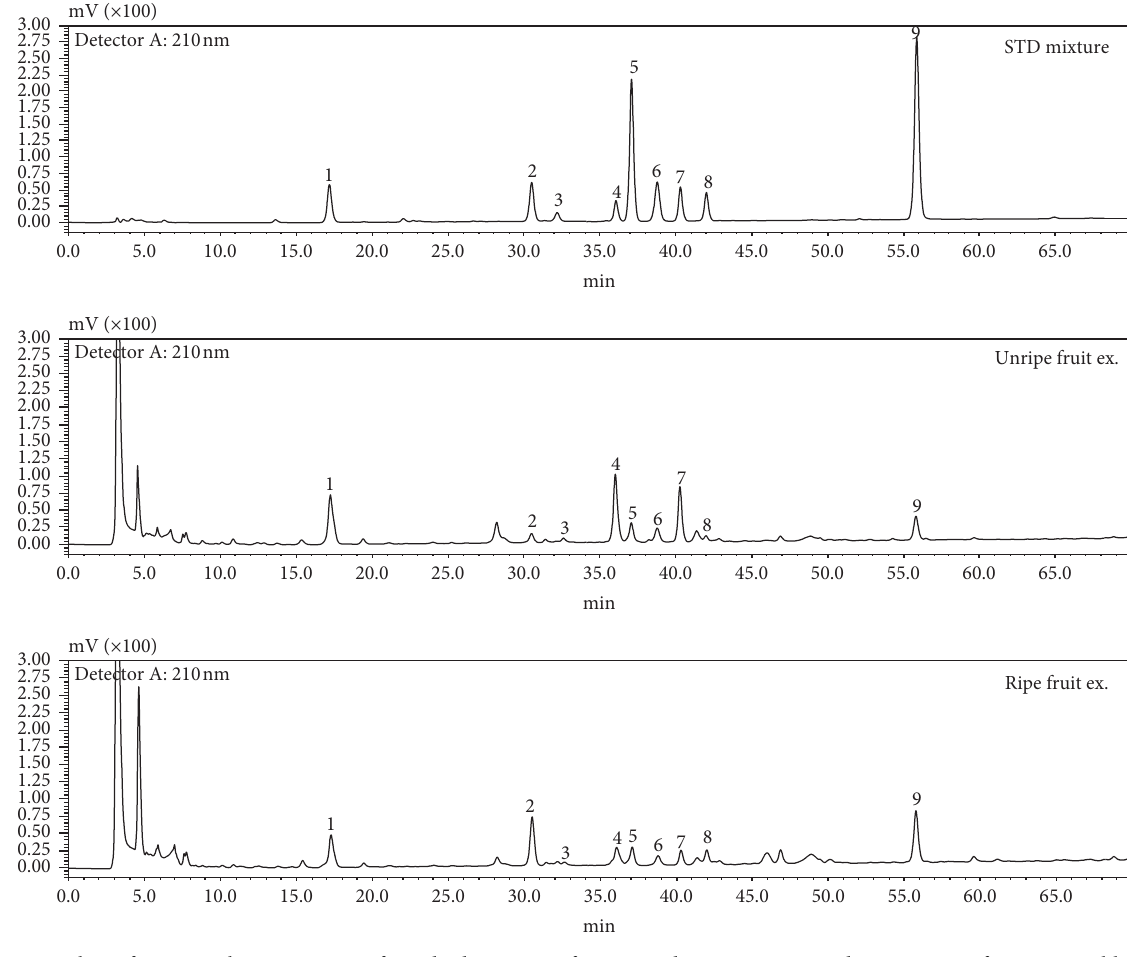
Figure 3: High-performance chromatograms of standard mixtures of compounds 1–9 in unripe and ripe P. mume fruits:1, neochlorogenic acid (NCA); 2, benzyl- β -D-glucopyranoside (BGP); 3, β -D-glucopyranosyl benzoate (GPB); 4, amygdalin; 5, 3, 4, 5-trimethoxyphenyl- β -D- glucopyranoside (TMPGP); 6, prunasin; 7, benzyl- α -L-arabinopyranosyl-(1 ⟶ 6)- β -D-glucopyranoside (BAPGP); 8, benzyl- β -D-xylo- pyranosyl-(1 ⟶ 6)- β -D-glucopyranoside (BXPGP); 9, ( − )-epicatechin). Table 4: The contents of compounds 1–9 in each part of the unripe and ripe P. mume fruits. Content of marker compounds in each part of fruits (mg/g) Compounds Ripeness Whole Seed Flesh